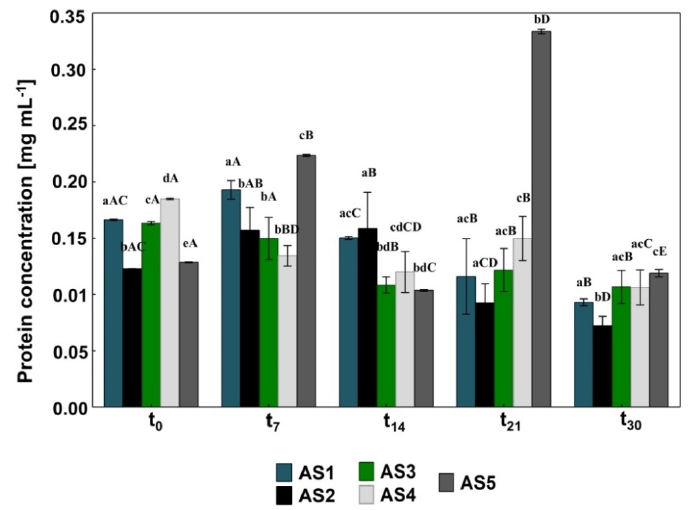
Figure 4. Protein concentrations (mg mL − 1 ) in the five assays (AS1–AS5) during 30 days of treatment. The data are presented as the mean values of three biological replicates ± standard deviation. The values of protein concentration with di ff erent lower-case letters (a, b, c, d, e) are significantly di ff erent ( p <